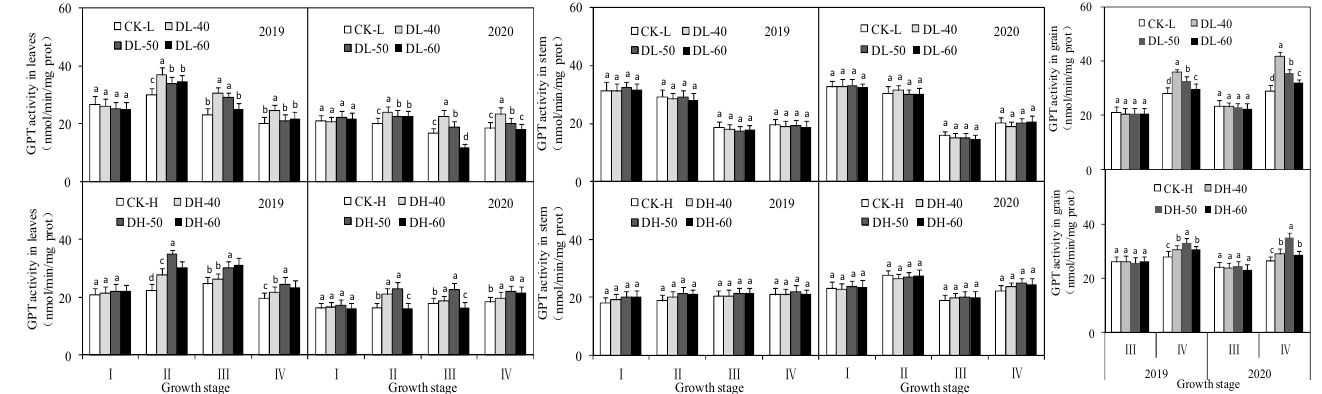
Figure 5. Effects of density and fertilization on GS activity in organs of forage maize. Note: Different letters on bars indicate significant differences among treatments at the 0.05 probability level.